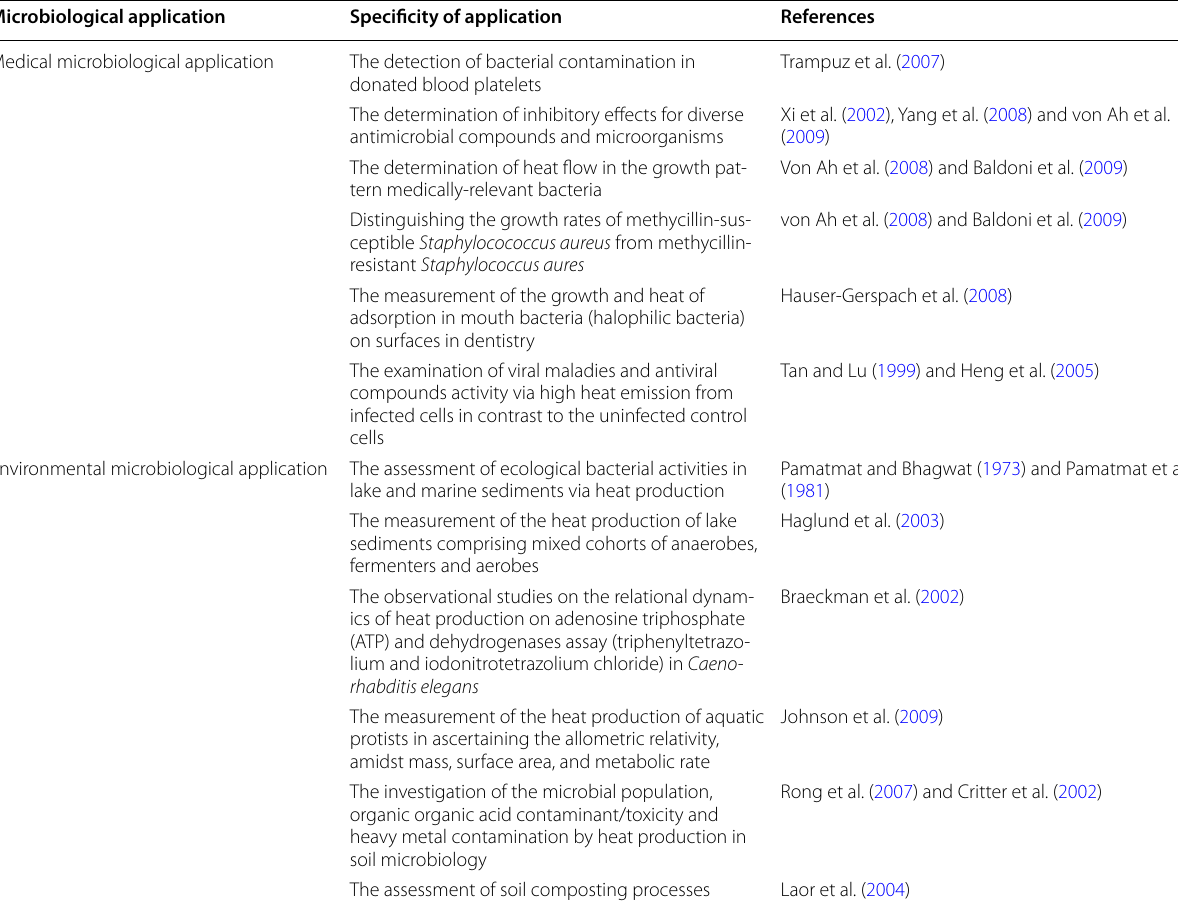
Table 1 Peculiarities of the isothermal microcalorimetry calscreener (IMC) in medical microbiology applications Microbiological